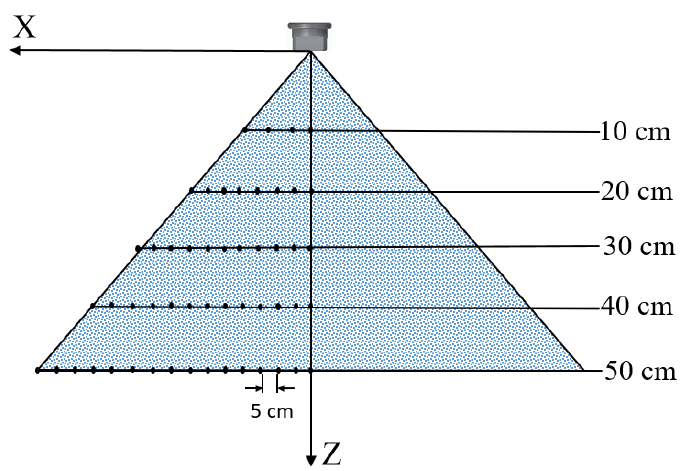
Figure 3. Sample point diagram of spray surface (black point as measuring point).